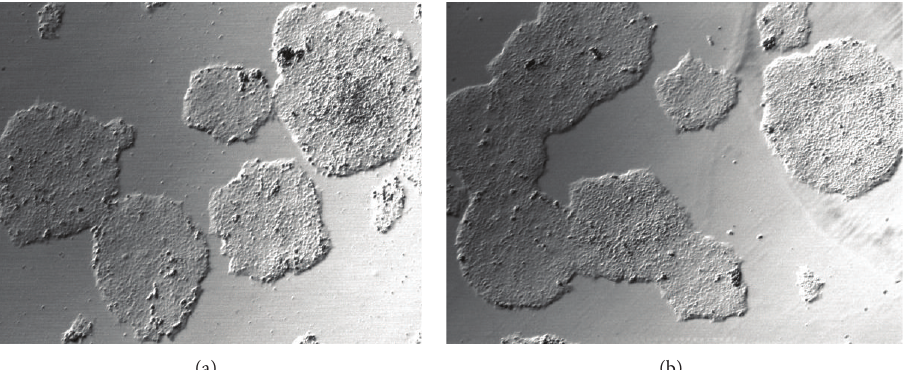
Figure 3: After 1 week or 6 months of storage at 4 ∘ C, no significant reduction in supporting activity was observed. (a) hESCs were grown on fixed xeno-free ECM coated plates that had been stored at 4 ∘ C for 1 week (10x); (b) hESCs were grown on plates that had been stored at 4 ∘ C for 6 months (10x).